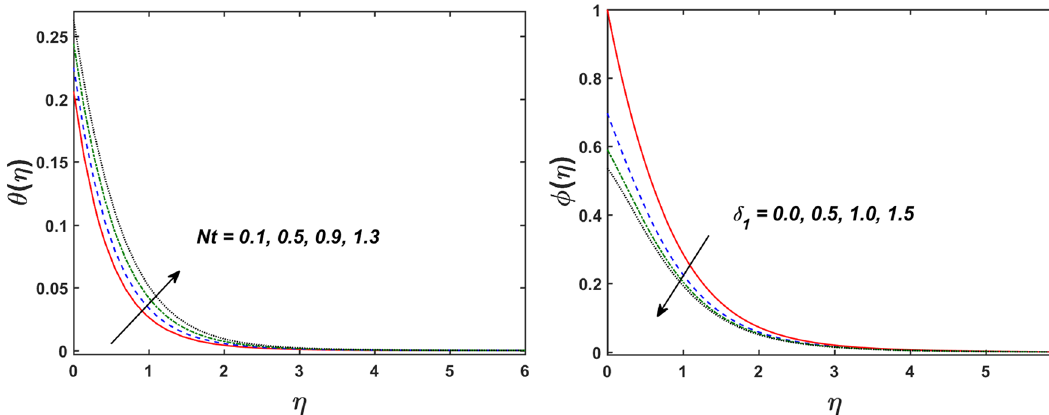
Figure 8. Variation in θ(η) for Nt and φ(η) for δ 1 .